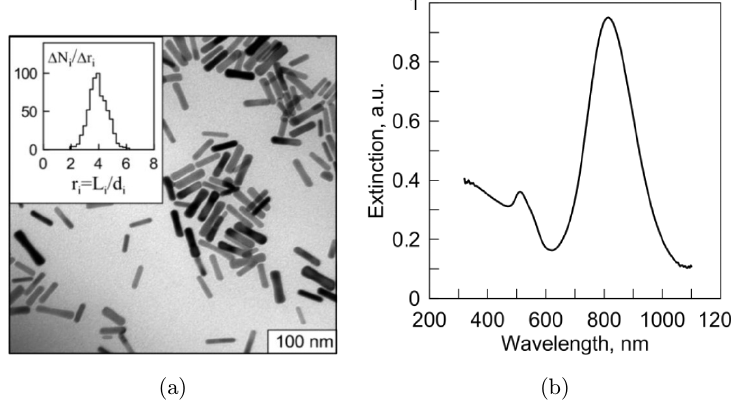
Fig. 1. (a) TEM image of gold nanorods. The insert in Fig. 1(a) shows the histogram of the numerical distribution of the particles = (cid:1) r r ¼ L = d (cid:1) N i i on the axial ratio i i i with the average value